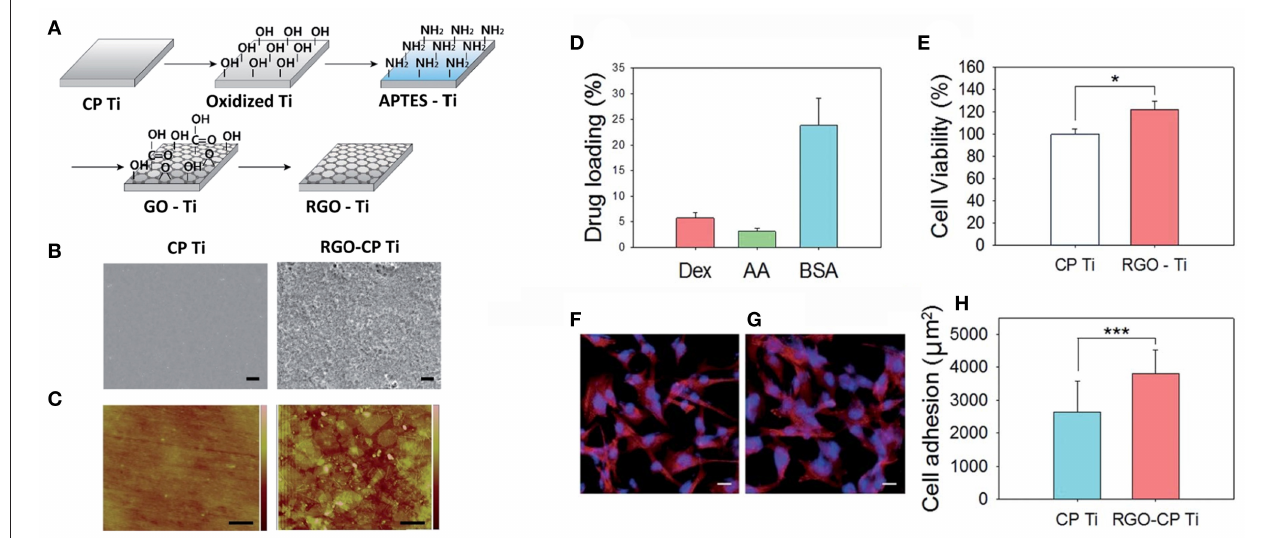
FIGURE 9 | (A) Schematic illustration for the preparation of rGO-Ti. (B) SEM images of Ti and rGO-Ti (scale bar = 2 µ m). (C) AFM images of Ti and rGO-Ti (scale bar = 500nm). (D) Drug loading (%) on rGO-Ti. (E) Relative cell viability on Ti and rGO-Ti. Confocal microscopic images of F-actin stained preosteoblasts on (F) Ti and (G) rGO-Ti (scale bar = 25 µ m). (H) Cell adhesion area determined from the region of F-actin fluorescence (* P ≤ 0.05 and *** P ≤ 0.001). Reproduced with permission from Jung et al. ( 130).